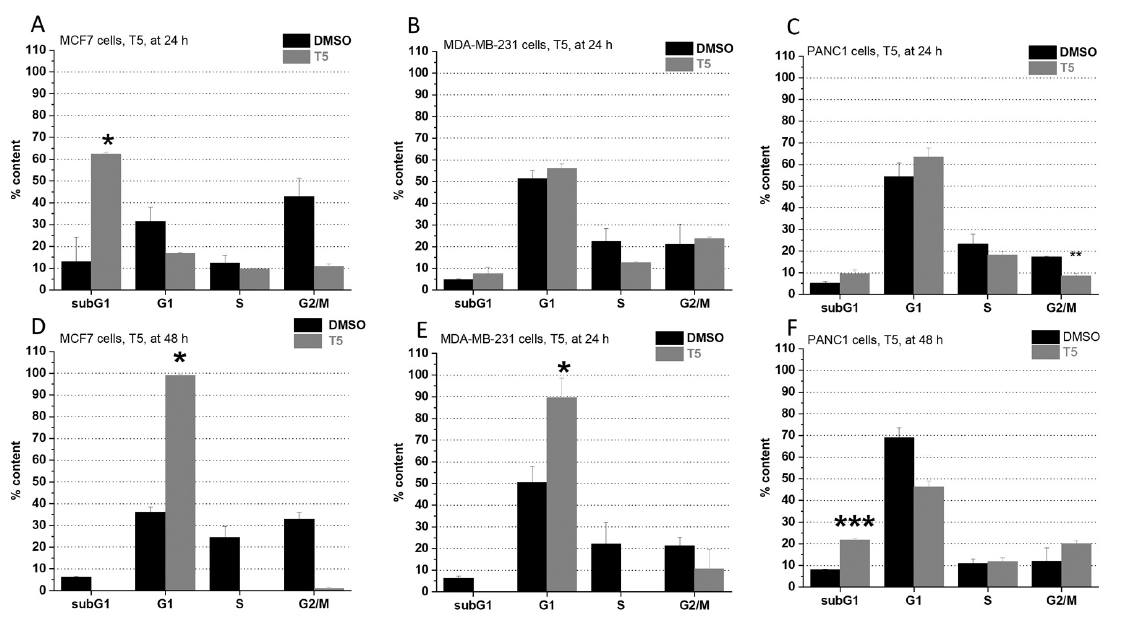
Figure 2. Impact of T5 on the cell cycle on MCF7 (( A ): at 24 h, ( D ): at 48 h), MDA-MB-231 (( B ): at 24 h, ( E ): at 48 h), and PANC1 cells (( C ): at 24 h, ( F ): at 48 h). Each cell line was treated with 25 µM. Each result represents the measurement of two parallel samples ( n = 2). Data are given as mean values ± standard deviation (SD). Asterisks mark the subpopulation, where the number of cells is significantly higher compared to the DMSO control, and a cell cycle arrest is seen ( p < 0.05: *, p < 0.01: **, p < 0.001: ***) determined by the One-way ANOVA test followed by Fisher’s LSD post hoc test.